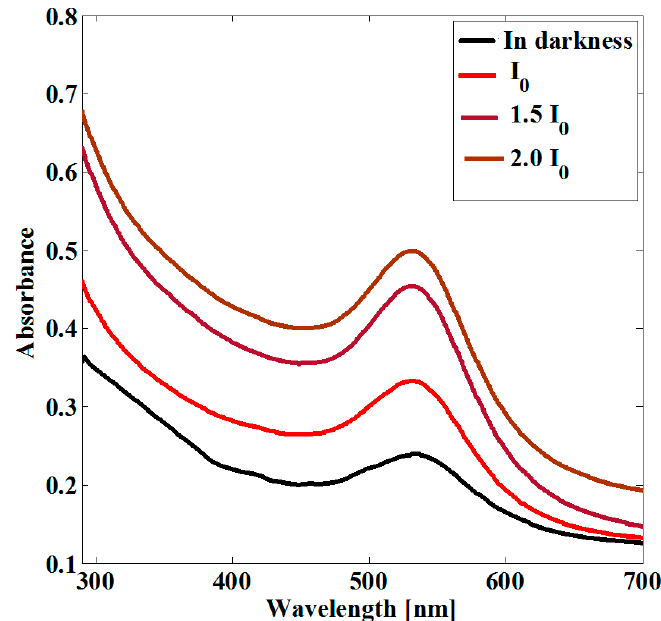
Figure 4. UV-vis absorbance spectra of the studied sample before and after nanosecond pulsed irradiation at 532 nm.